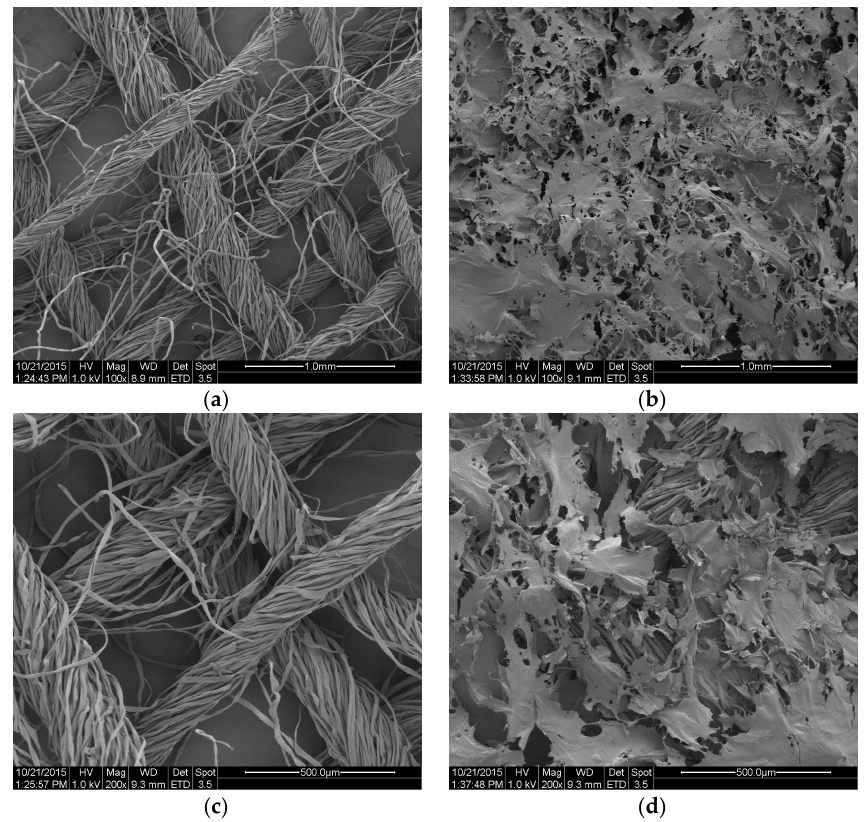
Figure 11. SEM microphotographs of: ( a ) gauze before impregnation (initial) at magnification 100×; ( b ) impregnated gauze at magnification 100×; ( c ) gauze before impregnation (initial at magnification 200×; and ( d ) impregnated gauze at magnification 200×.